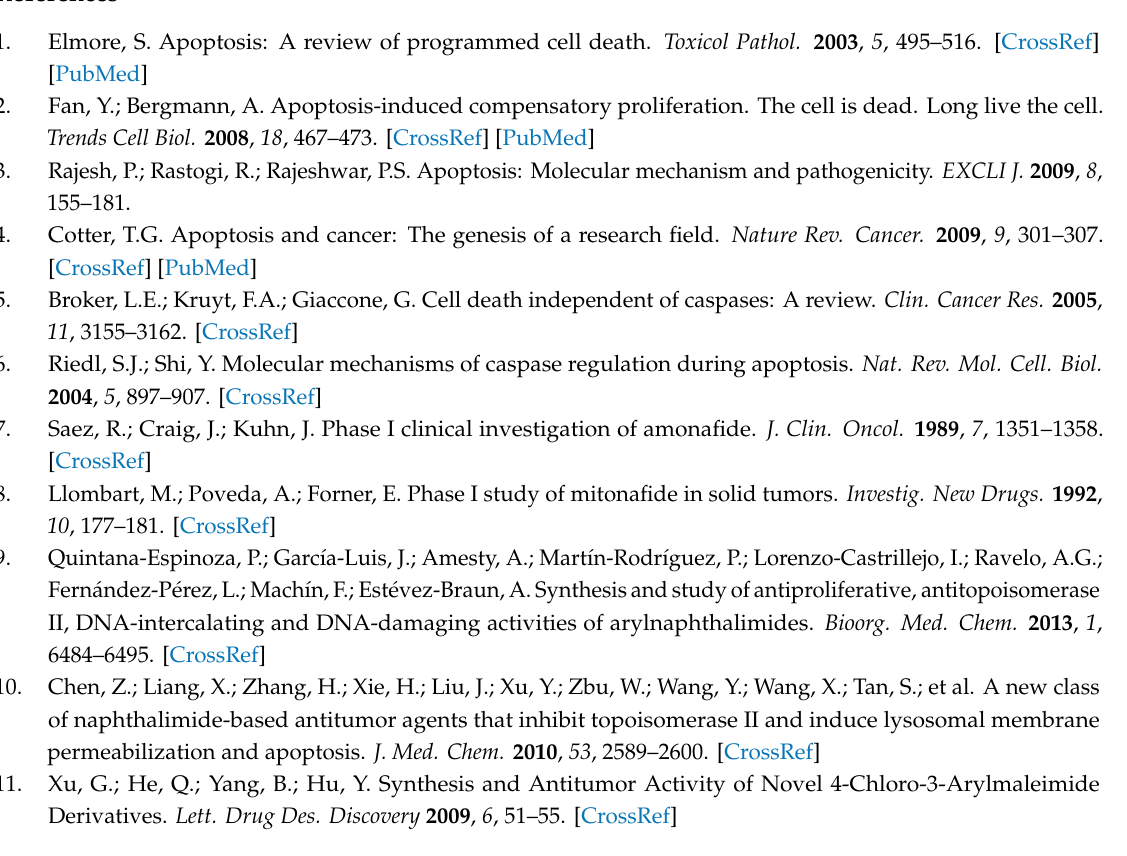
Figure S1: The numbering of atoms of derivative 6b used in the description of nuclear magnetic spectra, Figure S2: The numbering of atoms of compounds 7 – 9 used in the description of nuclear magnetic spectra, Table S1: Tests and cell lines used to characterize the biological activity of